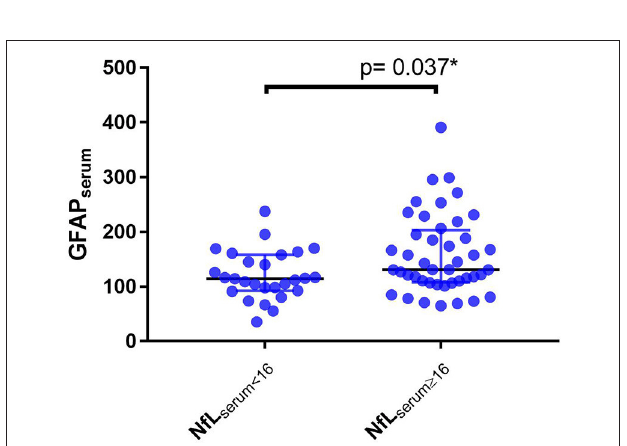
FIGURE 5 | Level of serum glial fibrillary acidic protein (GFAP serum ) in PPMS patients with serum neurofilaments light chain levels equal to or higher than 16 pg/ml (NfL serum ≥ 16) or lower the 16 pg/ml (NfL serum < 16), *Univariant general linear model corrected for age.